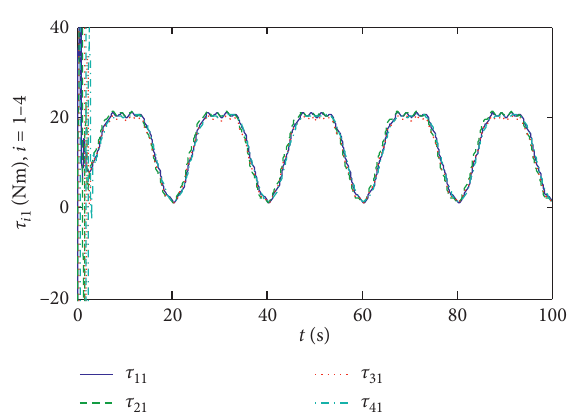
Figure 7: The control input torque τ